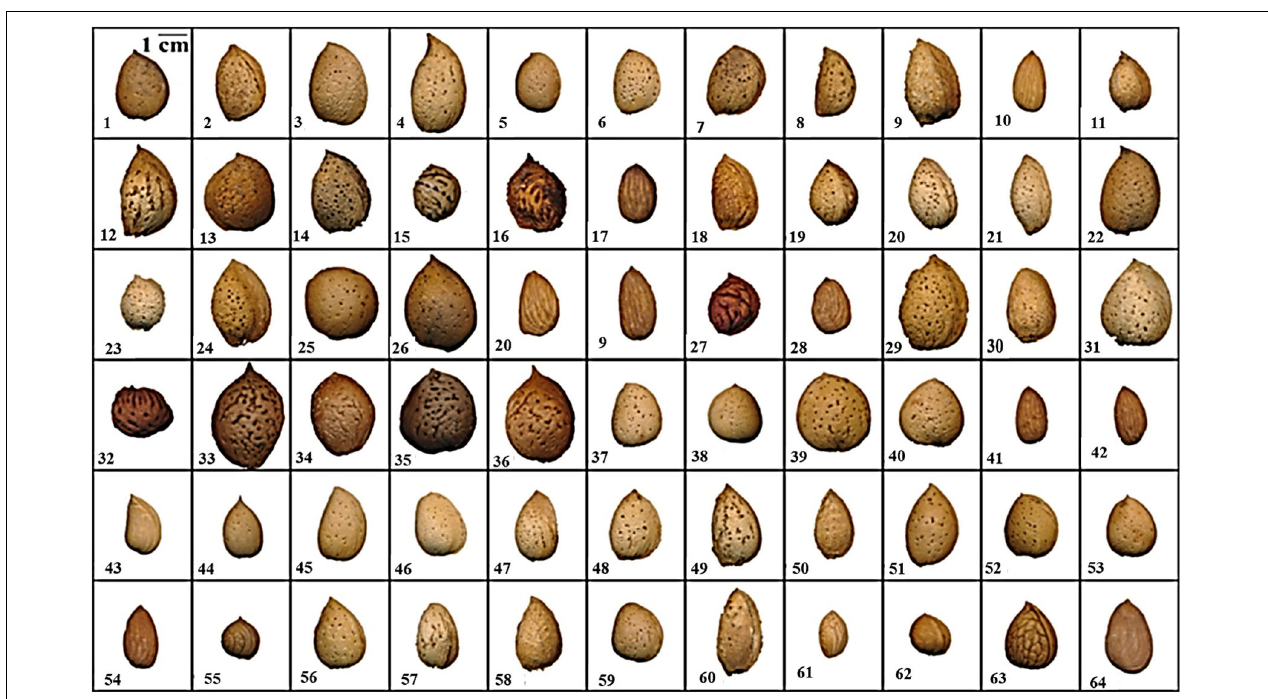
FIGURE 1 | Nut and kernel morphologies for an intra- and interspecific almond breeding germplasm. (Identifying numbers refer to the first column of Table 1 ).